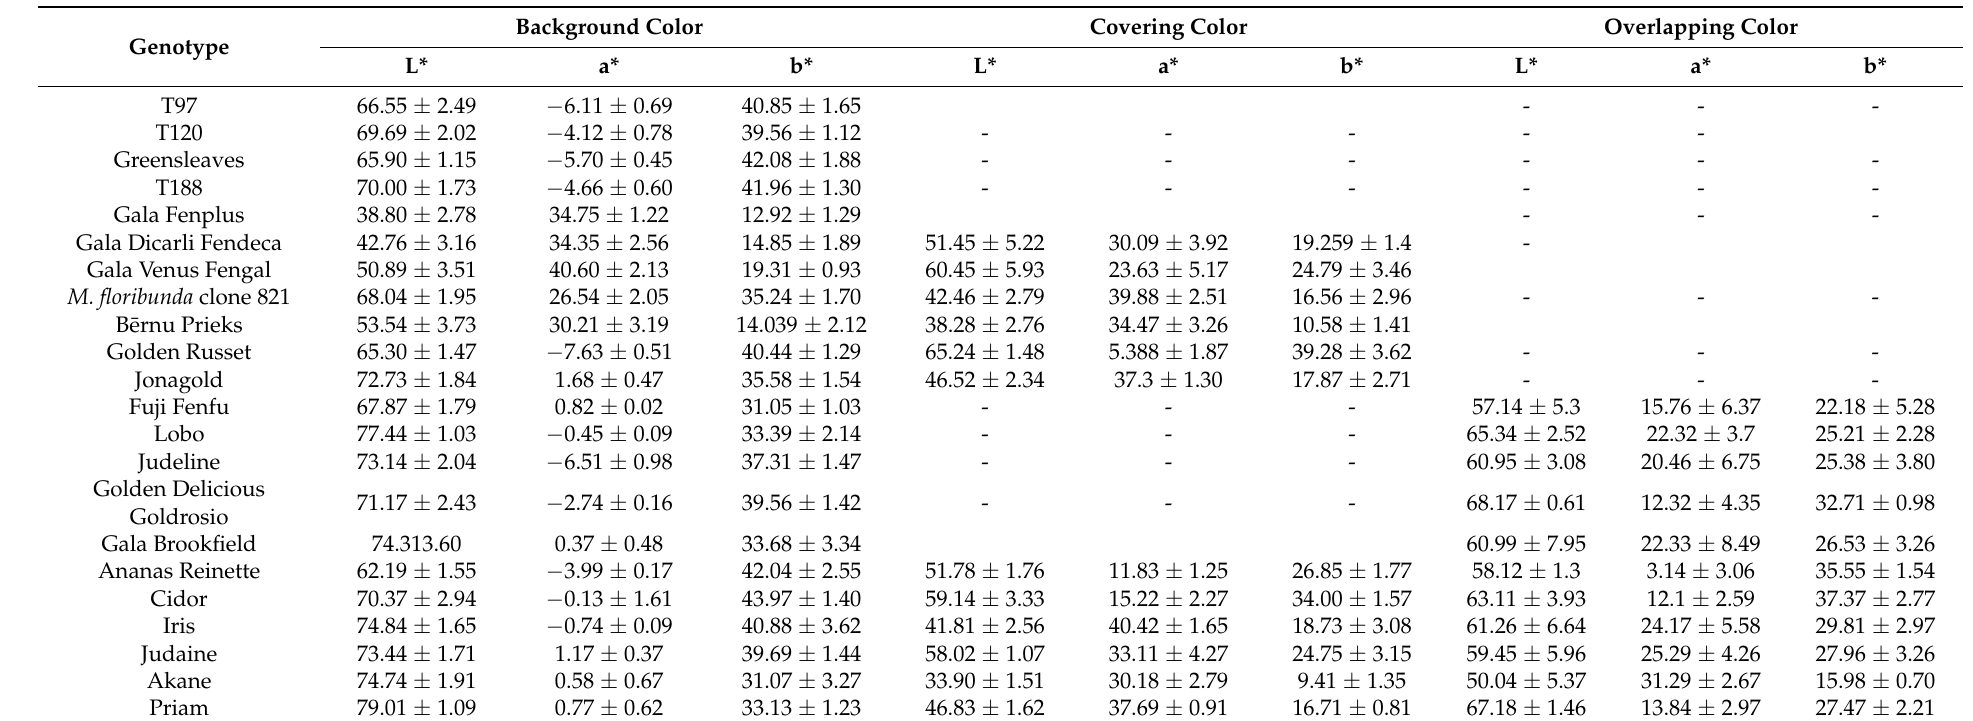
Table 4. The color parameters of different apple